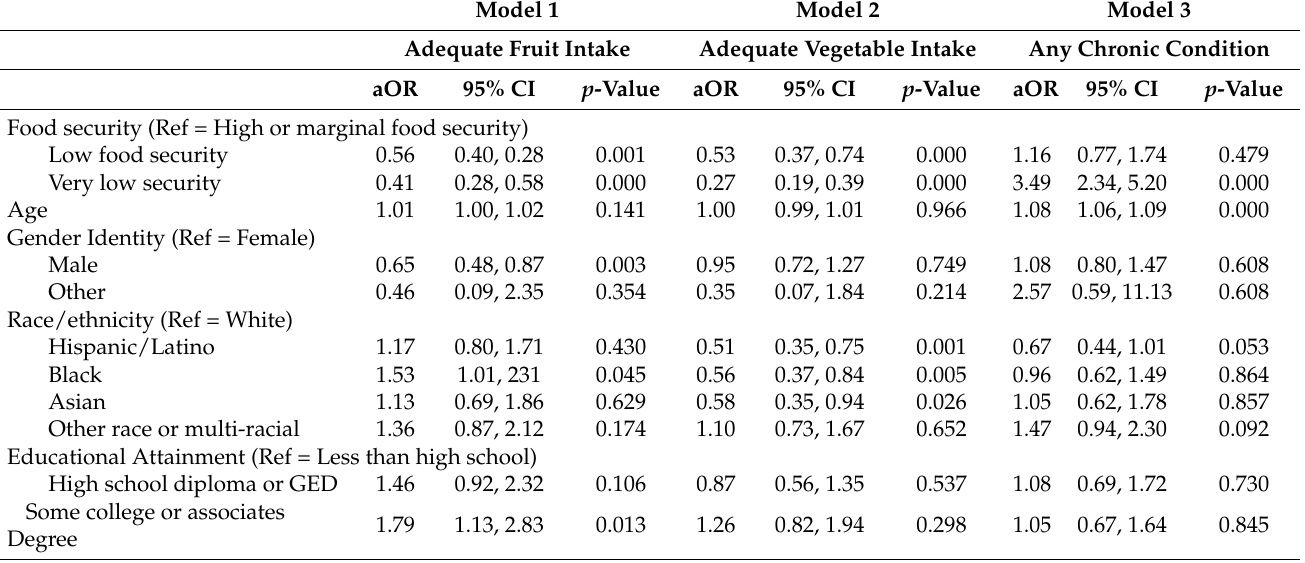
Table 2. Associations between food security and adequate fruit and vegetable intake and any chronic condition among participants who attended free food and produce distribution events in Los Angeles County, California,